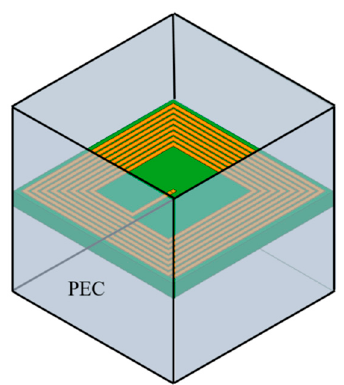
Figure 2. The setting of the designed MTM slab with four perfect electronic conductor (PEC) boundaries.